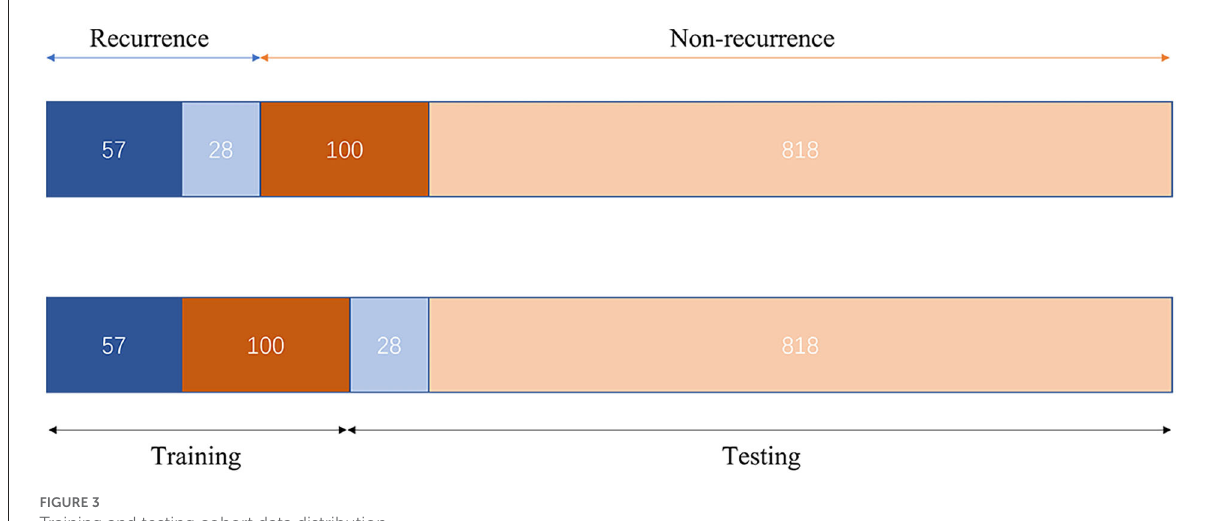
FIGURE3 Training and testing cohort data